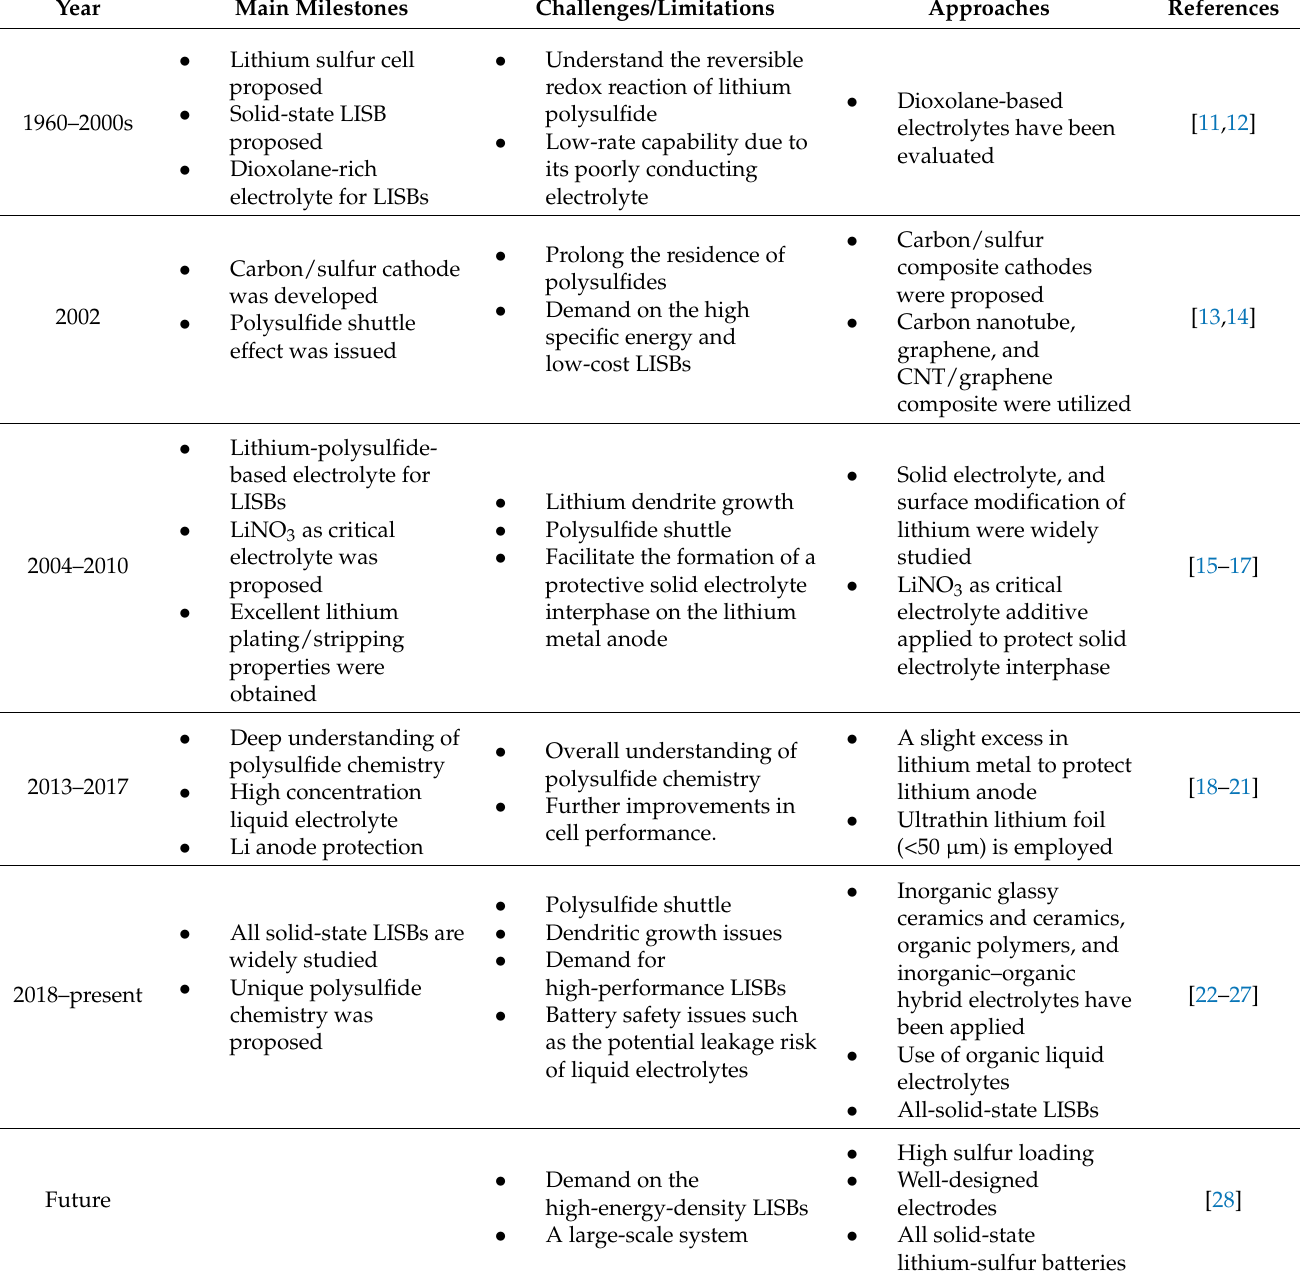
Table 1. Main milestones of the development in LISB